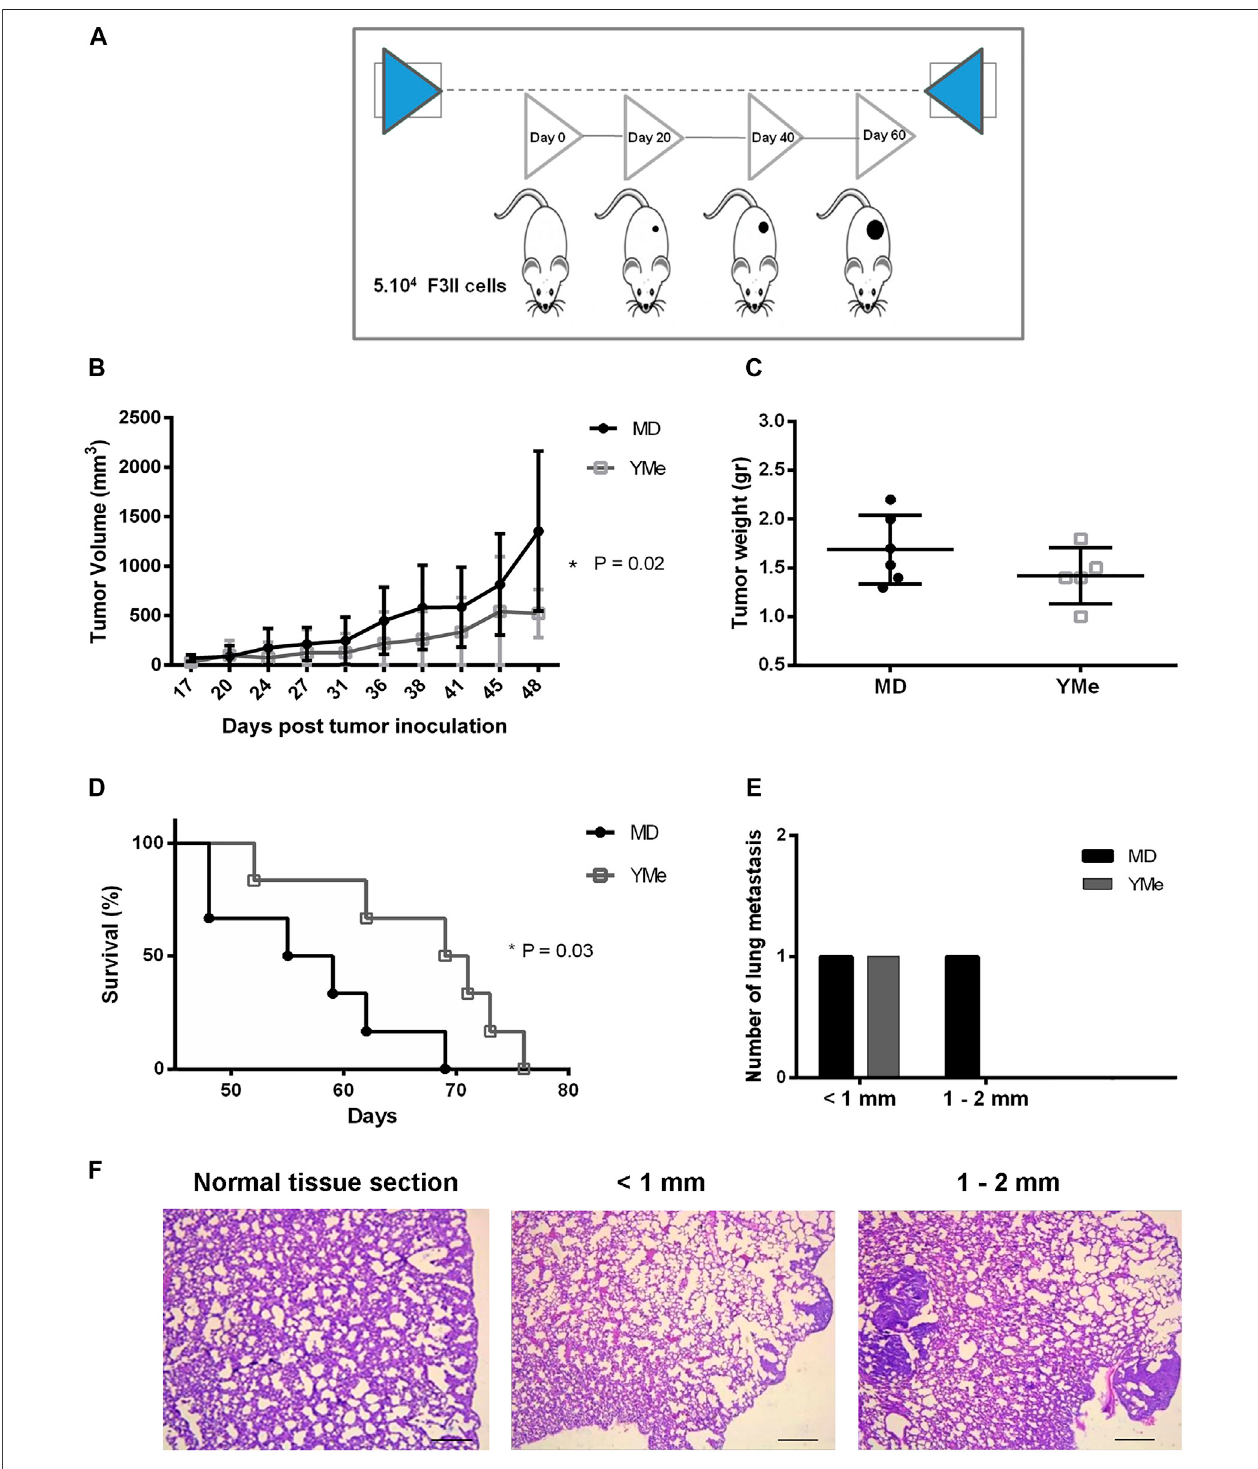
FIGURE6| EffectofYMeontumorprogressioninheterotopicBCmodel.BALB/cmicewererandomlyassignedinto2groups(n (cid:2) 6).ControlgroupdrankMD,the excipient of extract and treated group drank YMe 10 mg/ml. Both solutions were administered to the animal via the drinking water before (1 month) and after the inoculationofF3IItumorcells.Theanimalswereinoculatedsubcutaneouslywith5 × 10 4 cells/miceontheright fl ankoffemaleBALB/cmice.Attheendoftheexperiment, mice were sacri fi ced by cervical dislocation due to ethical considerations. (A) The timeline of the protocol is outlined in the scheme. (B) Tumor volumes, measured periodically with a caliper and calculated with the formula ½ (length x width 2 ) (length > width), are expressed as the mean and analyzed using unpaired Student ’ s t test